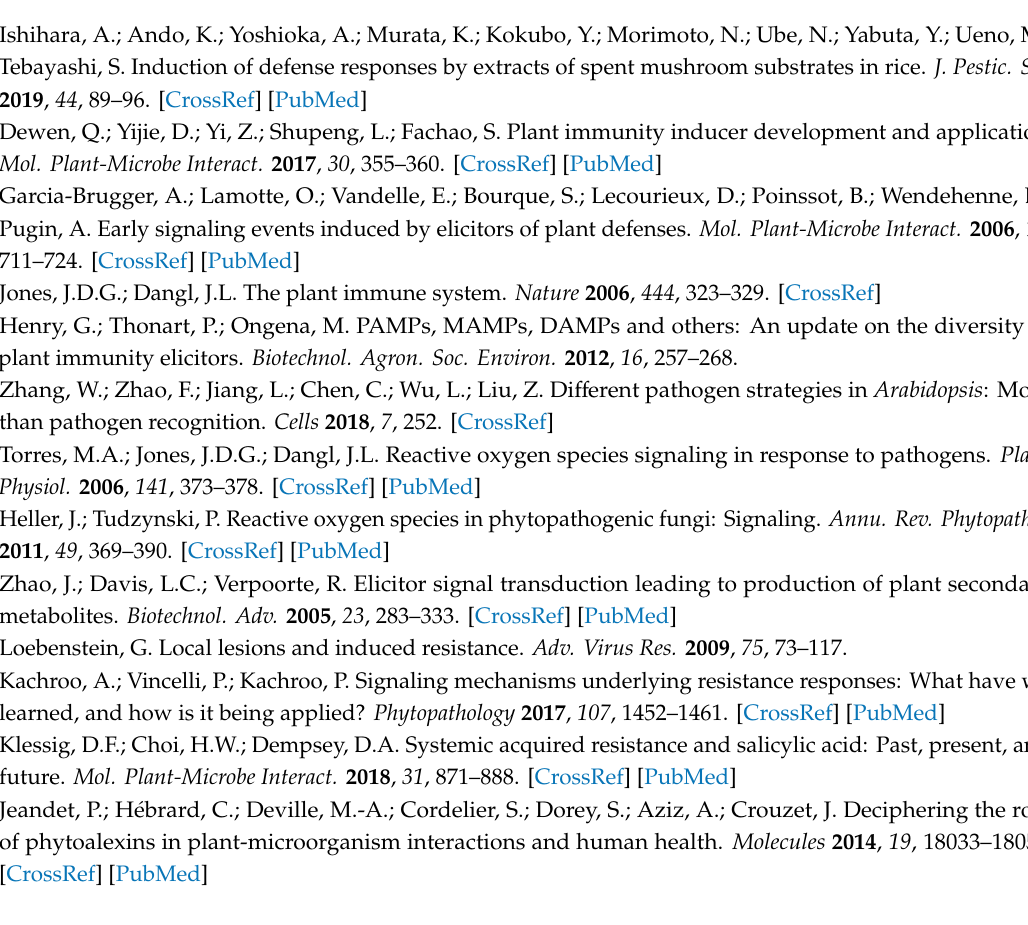
Figure SI-1: HPLC-UV chromatograms of aqueous extracts RME1 and RME2 prepared at 0.19% in polyphenols. Top figures relate to 2D spectra while bottom figures relate to chromatograms extracted at 278 nm. Figure SI-2: UPLC-HR-MS chromatogram of RME1 extract. Upper view for UV detection and bottom view for TIC detection. Figure SI-3: UPLC-HR-MS data for pentagallate glucose (G5). Figure SI-4: UPLC-HR-MS data for hexagallate glucose (G6 and G6 (cid:48) ). Figure SI-5: UPLC-HR-MS data for heptagallate glucose (G7). Figure SI-6: UPLC-HR-MS data for octagallate glucose (G8). Figure SI-7: UPLC-HR-MS spectra of commercial 1,2,3,4,6-penta-O-galloyl- β -D-glucopyranose and RME1. Figure SI-8: Macroscopic symptoms induced by gallic acid infiltration into tobacco